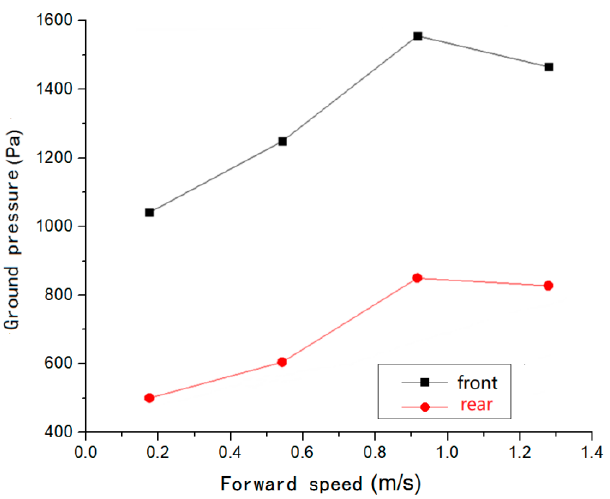
Figure 22. Relationship between the front and rear ground pressure and forward speed.